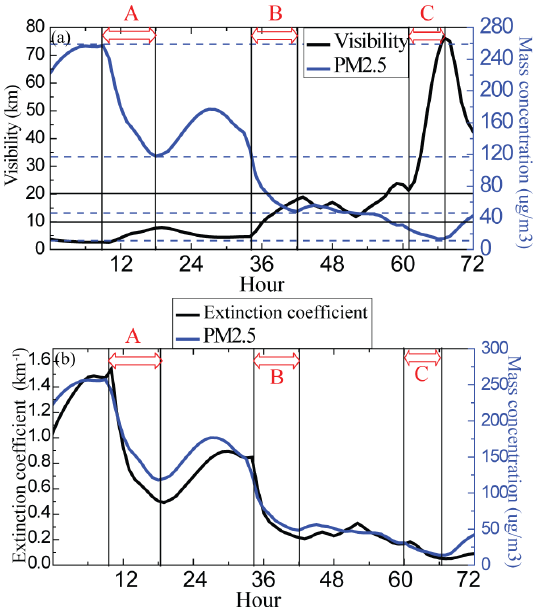
Figure 14. The time series of the regional-average visibility (km) vs. mass concentration of PM 2 . 5 (a) and extinction coefficient vs. mass concentration of PM 2 . 5 (b) from July 23 to 25 in